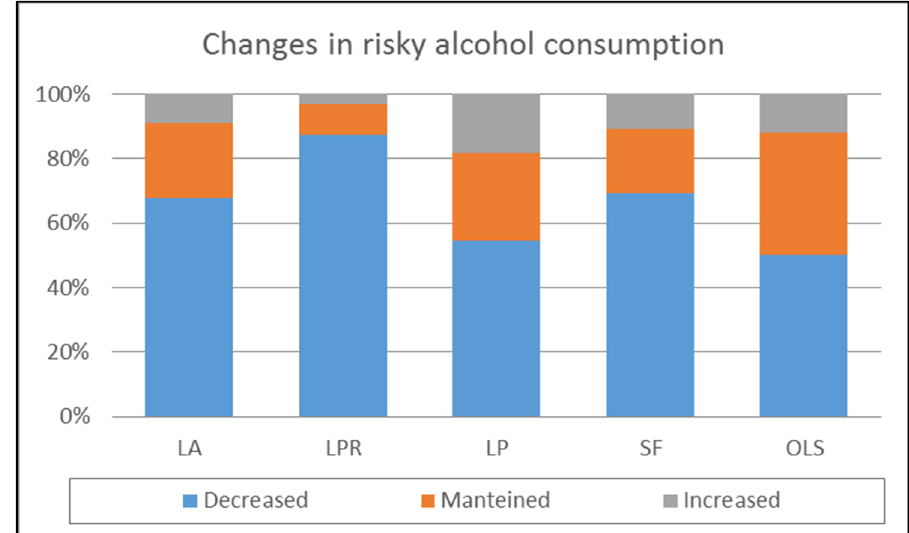
Figure 6. Changes in risky alcohol consumption during COVID-19 confinement considering the living situation. Note: LA = Lived alone; LPR = Lived with parents or other relatives; LP = Lived with partner; SF = Shared a flat with other people who were not the partner or family; OLS = Other living situations.